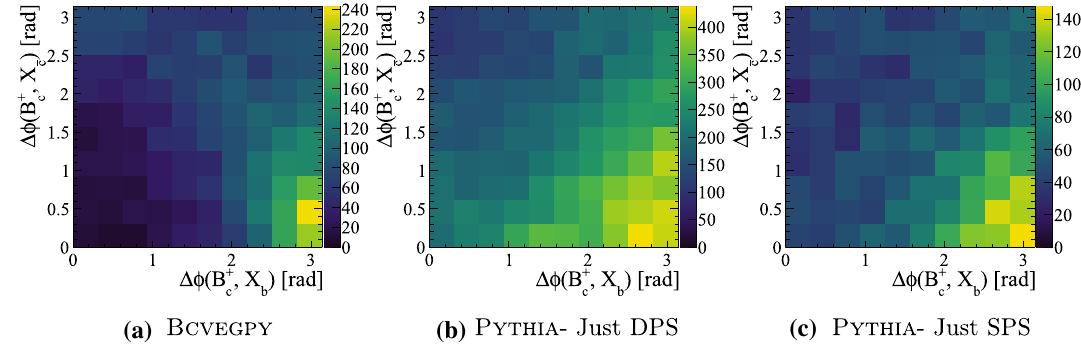
Fig. 18 Angular separation in the transverse view between B + c mesons and the associated X b or X ¯ c hadron in events generated with the BcVegPy and Pythia